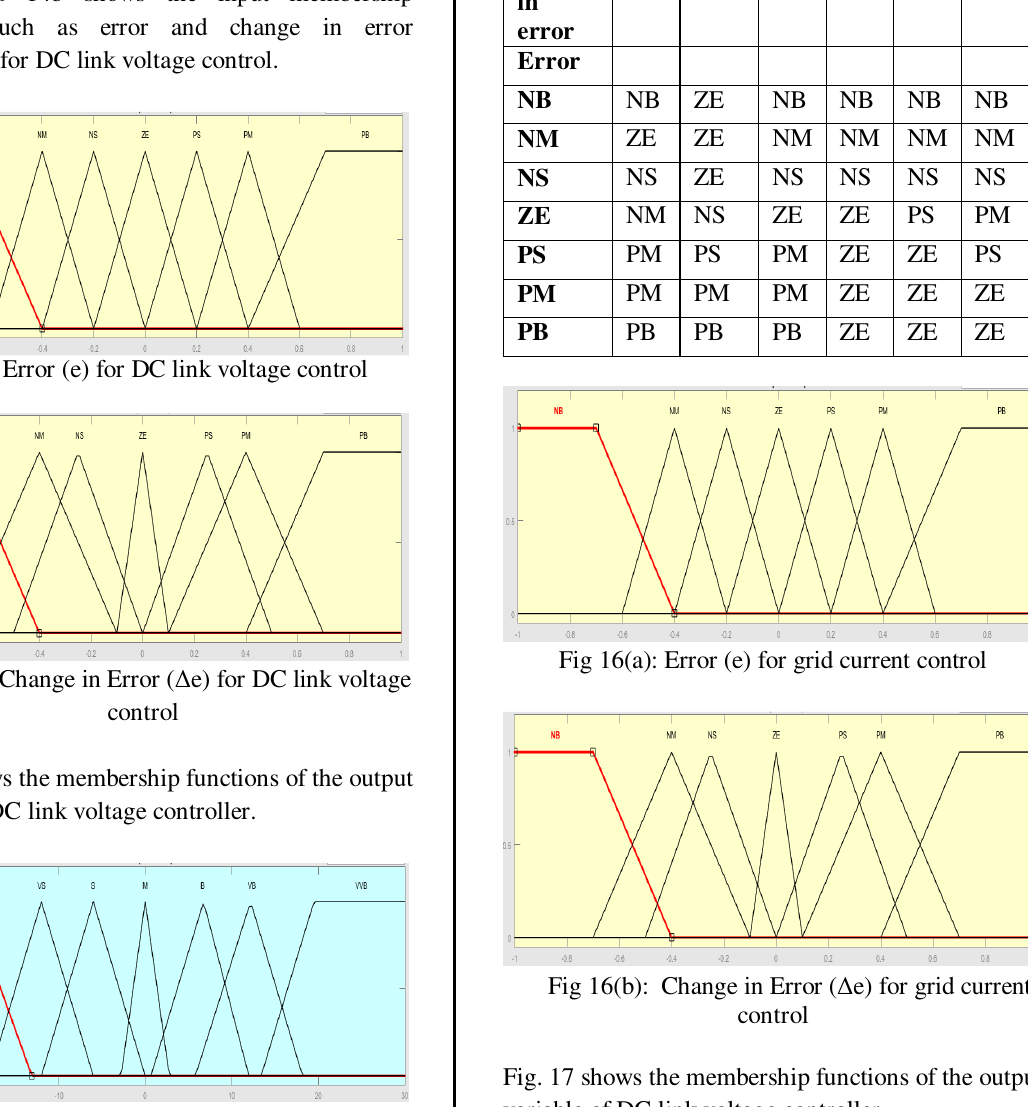
Fig.15: Output variable: Power reference